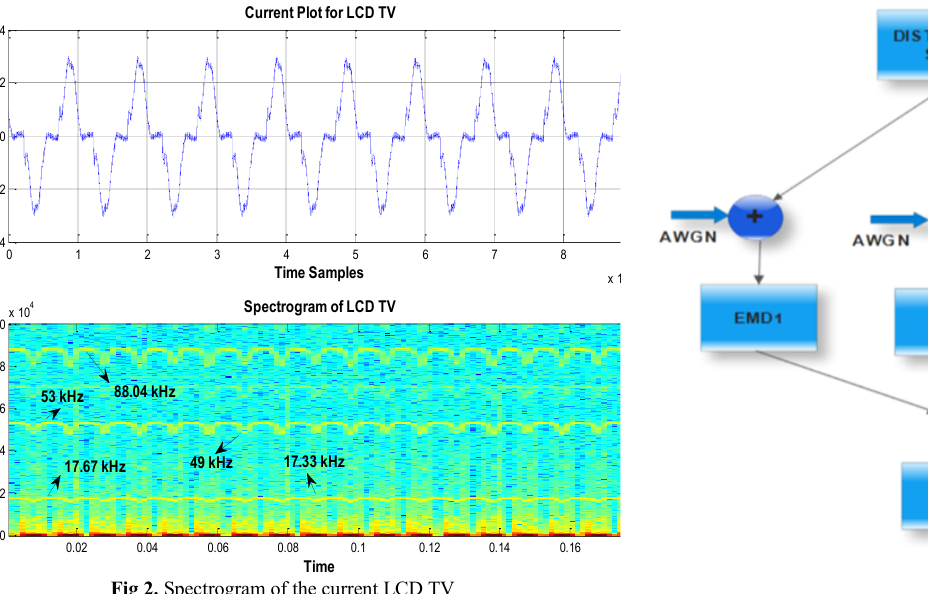
Fig 2. Spectrogram of the current LCD TV